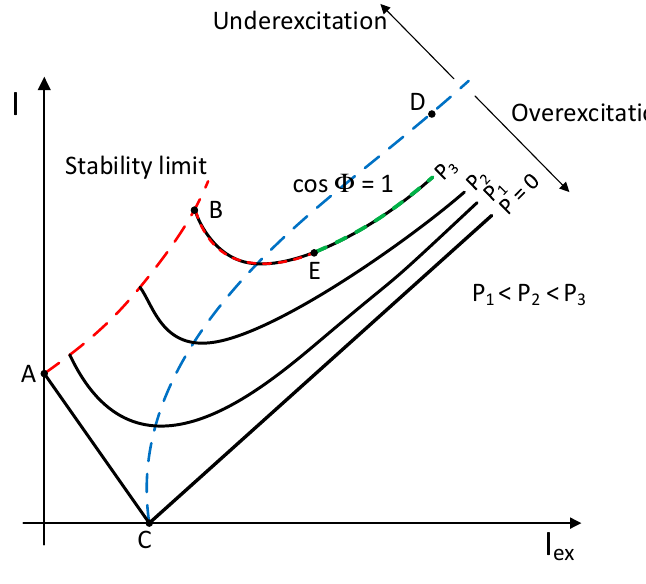
Figure 2. V-curve. Figure 2.